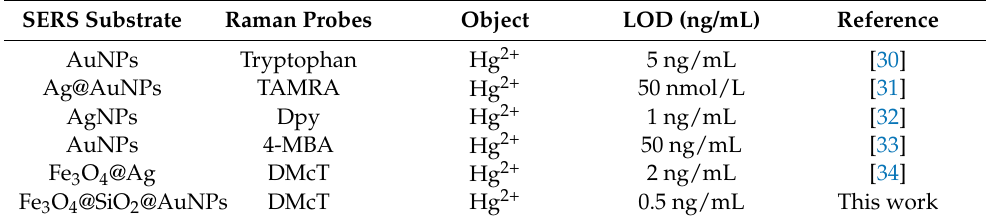
Table 3. Comparison of different SERS substrate and Raman